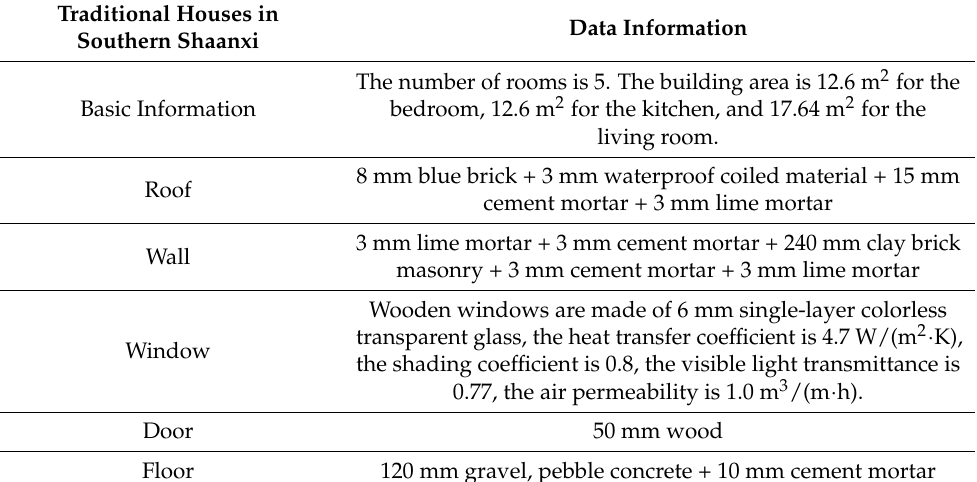
Table 1. Basic information in residential construction.